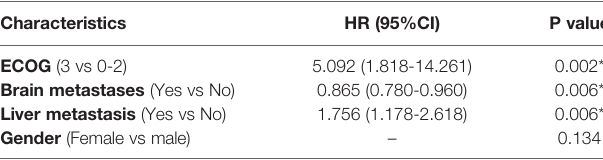
TABLE 6 | Multivariate analysis of PFS (COX regression analysis).